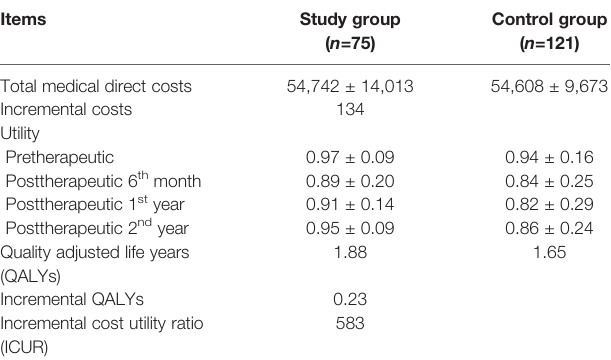
TABLE 6 | Cost utility analysis of the study group compared to the control group in patients with metastatic colorectal cancer over a 2-year time horizon ( N